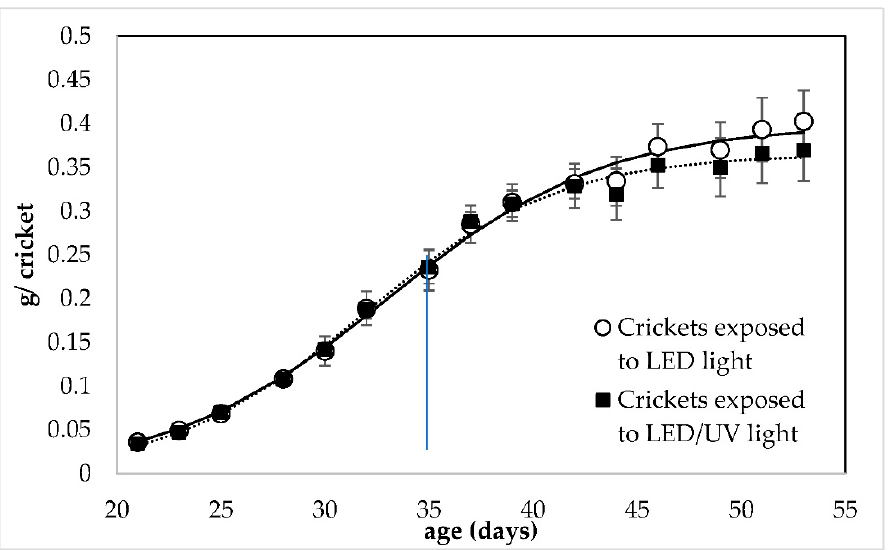
Figure 1. Growth of Acheta domestica (individual weight) reared under LED irradiation without ( ○ ) and with narrowband UV-B at 285 nm ( ▪ ). Error bars represent the standard deviation of multiple replications of the measurements ( n = 5). Dashed lines represent the fitting of experimental data to Equation (3). The small line that is vertical to the x -axis indicates the time when crickets reached adulthood (35 days of age).